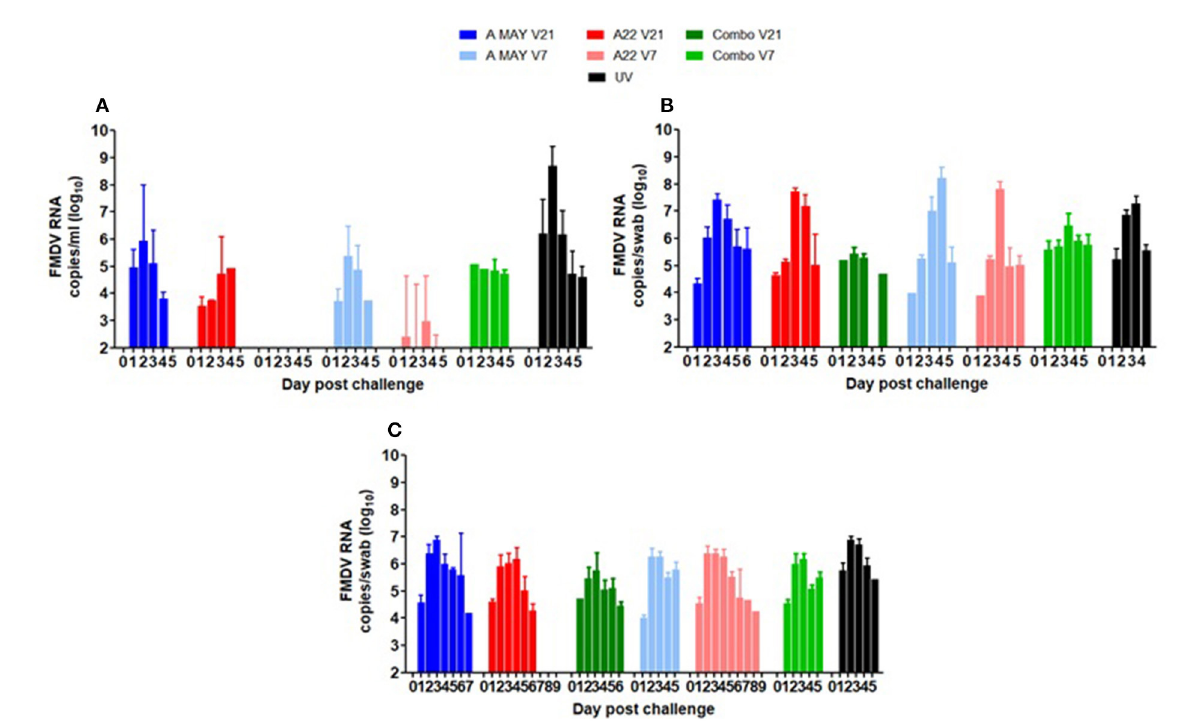
FIGURE4 Mean viral loads as (A) Log 10 FMDV RNA copies/ml in serum indicative of viraemia and Log 10 FMDV RNA copies/swab indicative of virus shedding in (B) oral swabs and (C) nasal swabs. The error bars show the standard deviation of the mean. Since many pigs were euthanised due to the appearance of lesions and attaining humane endpoints, the numbers in the day post-challenge differ with different